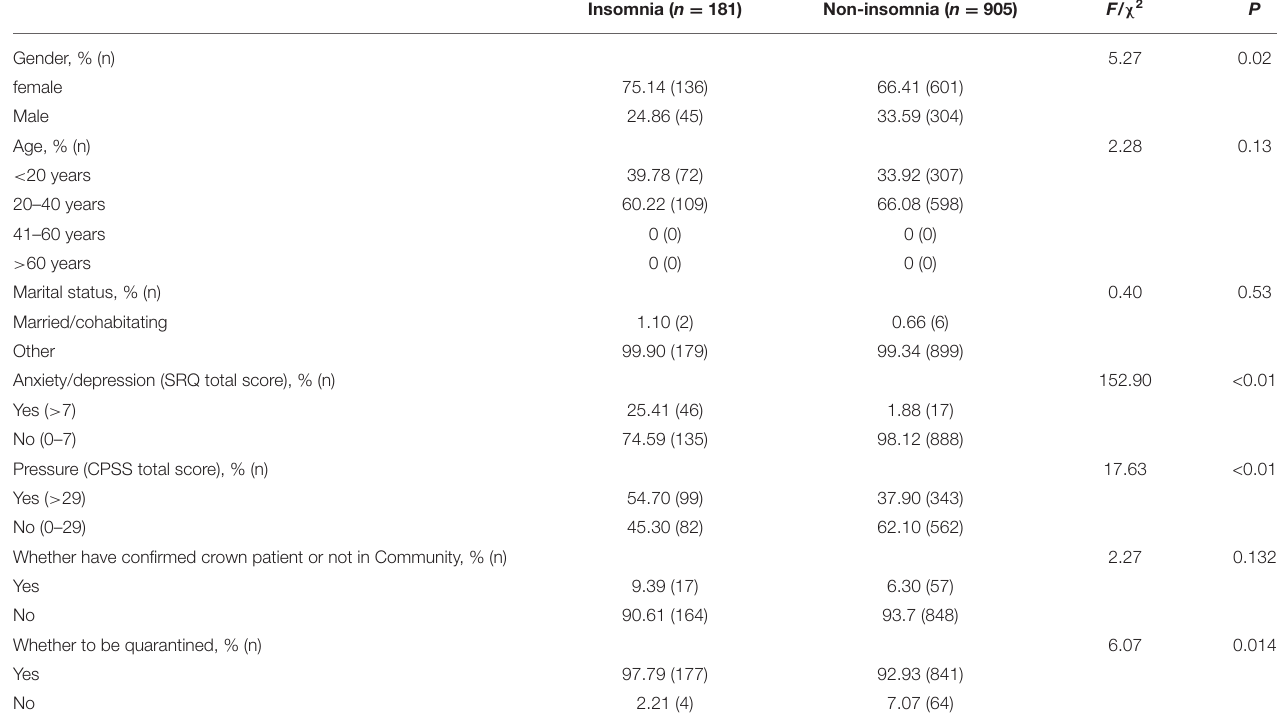
TABLE 1 | Basic demographic and clinical characteristics of college